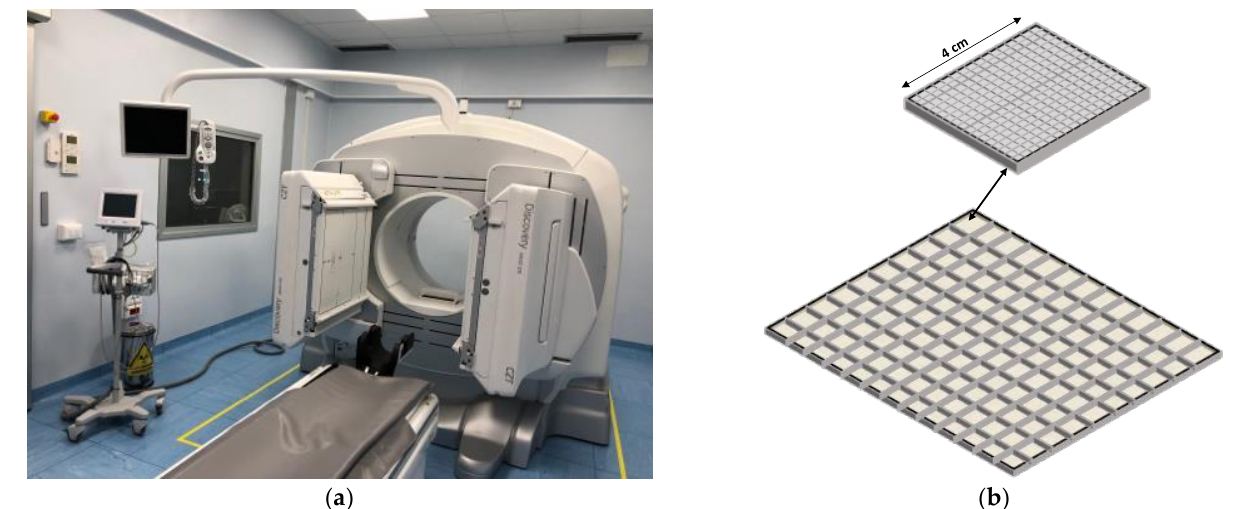
Figure 2. Discovery NM/CT 670 CZT system: ( a ) the machine, ( b ) detectors arrangement.